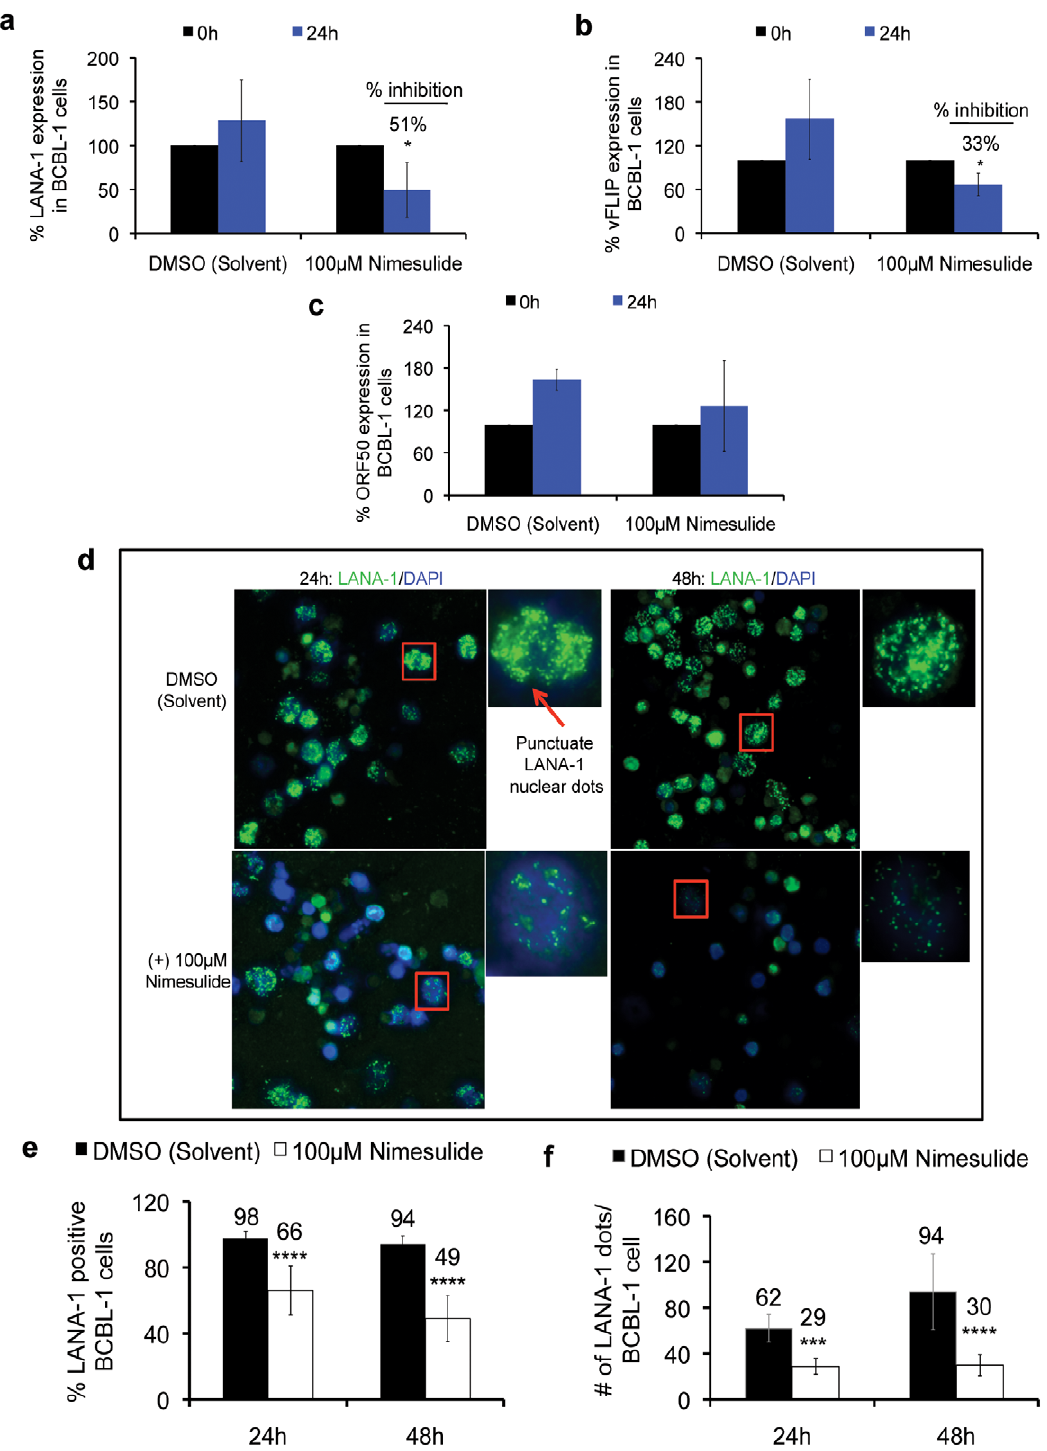
Figure 5. Effect of nimesulide on KSHV gene expression. ( a–e ) 5 6 10 5 BCBL-1 cells were seeded with 100 m M nimesulide, DMSO or left untreated (UN) without replenishment with fresh media. RNA was isolated at 24 h post-treatment with the drug to examine the gene expression levels of LANA-1 ( a ), v-FLIP ( b ), and ORF50 ( c ) by real-time RT-PCR. The cells were neither replenished with fresh media nor supplemented with the drugs. The percent inhibition and statistics (t-test) were calculated with respect to untreated for each treatment (*) p , 0.05. ( d–e ) In parallel experiments, LANA-1 protein was examined by immunofluorescence using anti-LANA-1 antibody ( d ) and used to calculate the percentage of cells positive for LANA-1 ( e ) at 24 h and 48 h post-treatment from 500 randomly selected cells. ( f ) Levels of LANA-1 protein per cell were measured by examining the number of LANA-1 dots/BCBL-1 cell by manually counting the number of ‘punctate nuclear LANA-1 dots’ in 20 BCBL-1 cells positive for LANA-1 from each treatment. ( e–f ) The indicated means are the averages calculated from cells selected from different fields by two observers. The corresponding statistics (t-test) were calculated with respect to DMSO treatment for each time point. ( a–c, e, f ) Each experiment was done in tripicate, and each point represents the average 6 S.D. from three independent experiments (*) p , 0.05, (****) p , 5*10 2 10 .